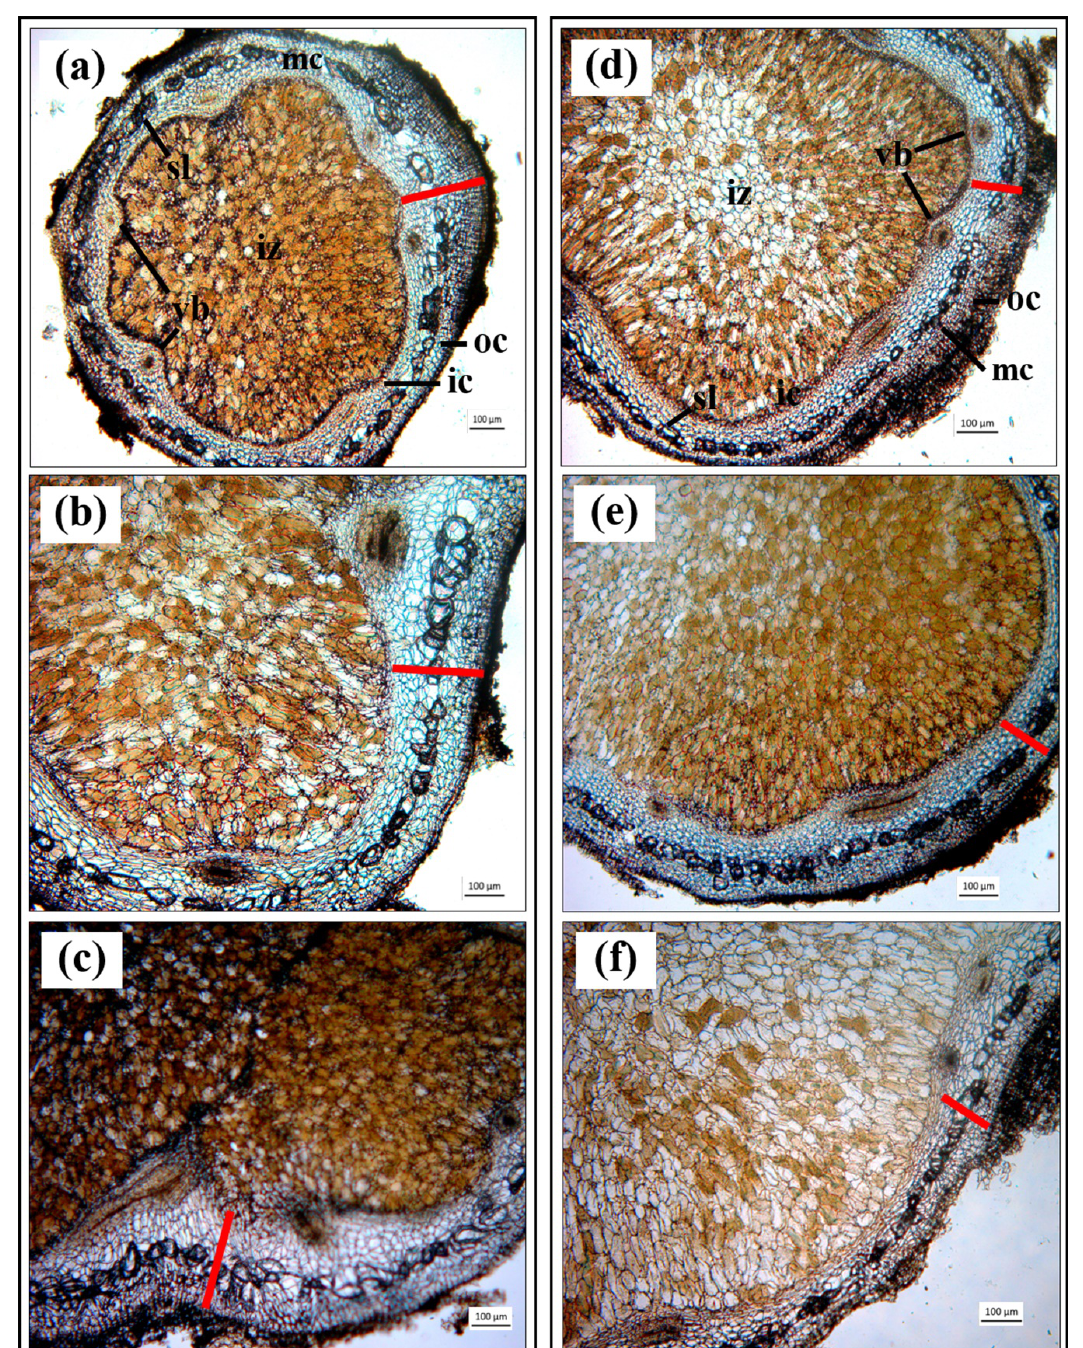
Figure 7. Comparison of soybean nodule cross section under light compound microscope between single inoculation of USDA110 and co - inoculation of USDA110 with S141 at 45 DAI : ( a ) small nodule of single inoculation; ( b ) medium nodule of single inoculation; ( c ) large nodule of single inoculation; ( d ) small nodule of co - inoculation; ( e ) medium nodule of co - inoculation; and ( f ) large nodule of co - inoculation . iz, infected zone; ic, inner cortex; mc, middle cortex; oc, outer cortex; vb, vascular bundles; sl, sclerid layer . Red bar indicates length of cortex zone .